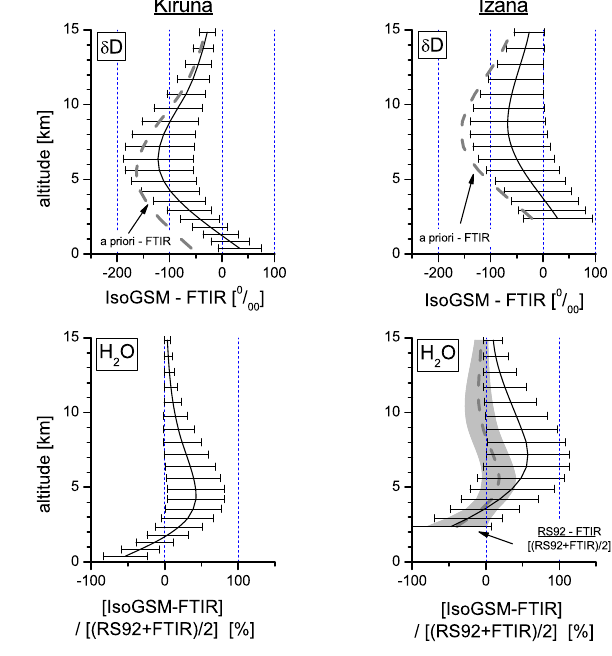
Fig. 3. FTIR Averaging kernels for H 2 O (bottom panels) and δ D (expressed as ln [ HDO ] [ , top panels). Left panels for Kiruna and right Fig. 4. Statistics for the difference between coincident FTIR pro- H 2 O ] panels for Iza˜na. file measurements and IsoGSM profile simulations. Bottom panels: H 2 O, top panels: δ D. Left panels: Kiruna, right panels: Iza˜na. The grey area in the right bottom panel shows the comparison between Vaisala RS92 and FTIR measurements (grey dotted line: mean; grey area: 1 σ standard deviation). The grey dotted lines in the top pan- els show the difference between the mean retrieved FTIR δ D values and the a priori δ D profile, which has been constructed from in-situ δ D